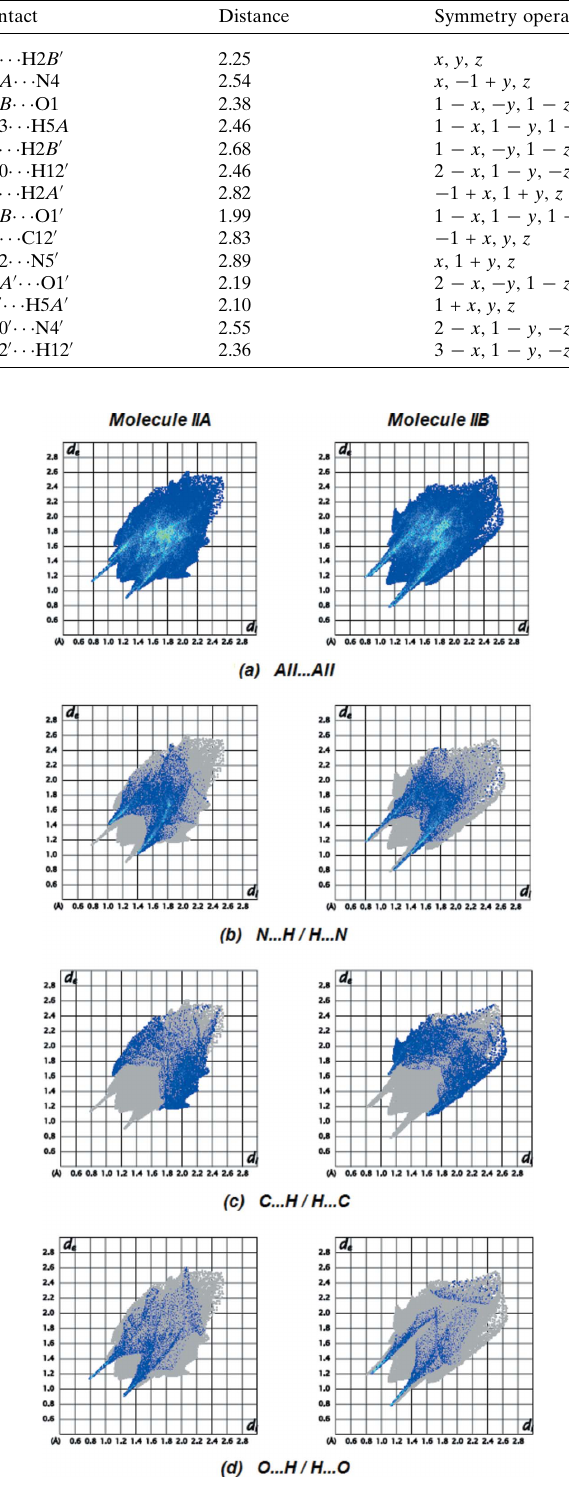
Figure 9 The full two-dimensional fingerprint plots for molecules (IIA) and (IIB), showing all interactions ( a ) and those delineated into N (cid:2)(cid:2)(cid:2) H/H (cid:2)(cid:2)(cid:2) N ( b ), C (cid:2)(cid:2)(cid:2) H/H (cid:2)(cid:2)(cid:2) C ( c ) and O (cid:2)(cid:2)(cid:2) H/H (cid:2)(cid:2)(cid:2) O ( d ) interactions. The d i and d e values are the closest internal and external distances (in A˚ ) from given points on the Hirshfeld surface.